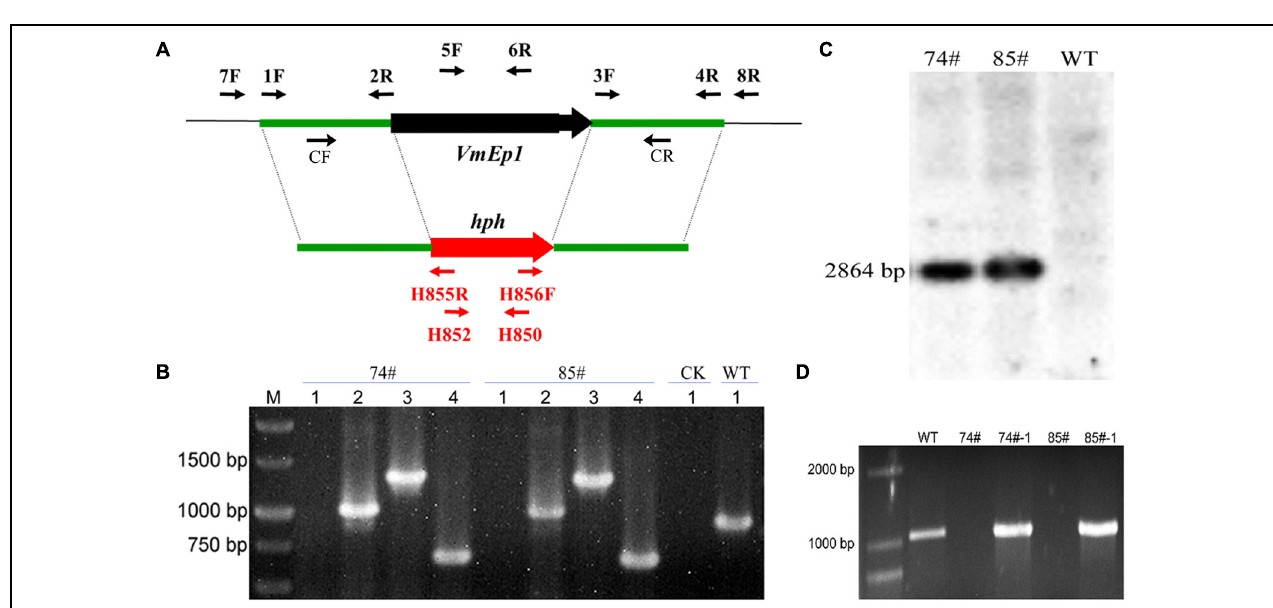
FIGURE 4 | Generation and identification of VmEp1 deletion and complementation mutants. (A) Gene replacement strategy of VmEp1 . Primer pairs 1F/2R and 3F/4R used for WT amplicon. The hygromycin-resistance cassette ( hph ) is denoted by the large red arrow. Primer binding sites are indicated by black arrows (see Supplementary Table S2 for primer sequences). (B) Identification of VmEp1 knockout